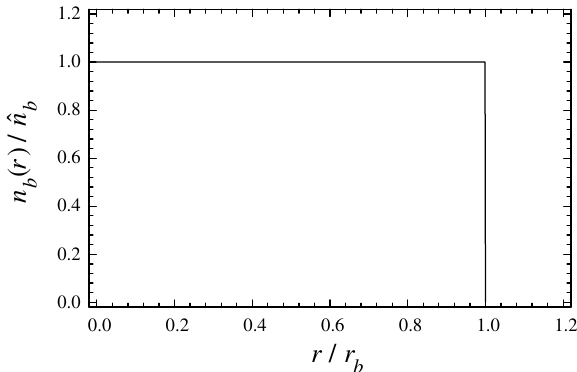
(cid:1) r (cid:3) = ^ nn versus r=r b b b ! 1 . b